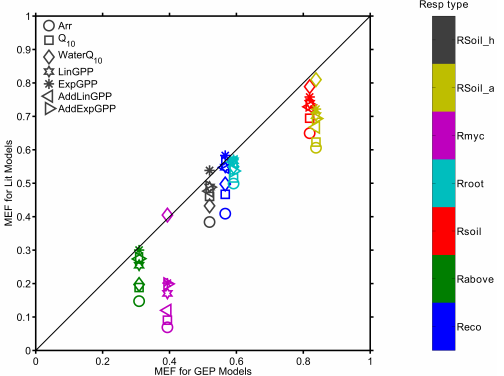
Figure 14. MEF validation values for literature models and for the best GEP model in terms of MEF at each respiration level. Each R eco flux component is shown in a separate